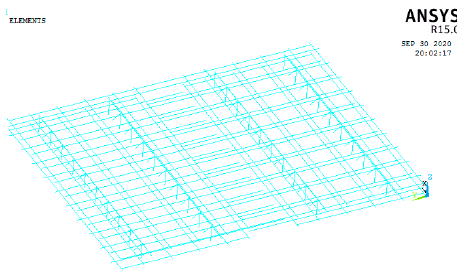
Figure 25. The cast-in-place layer model of a composite slab.